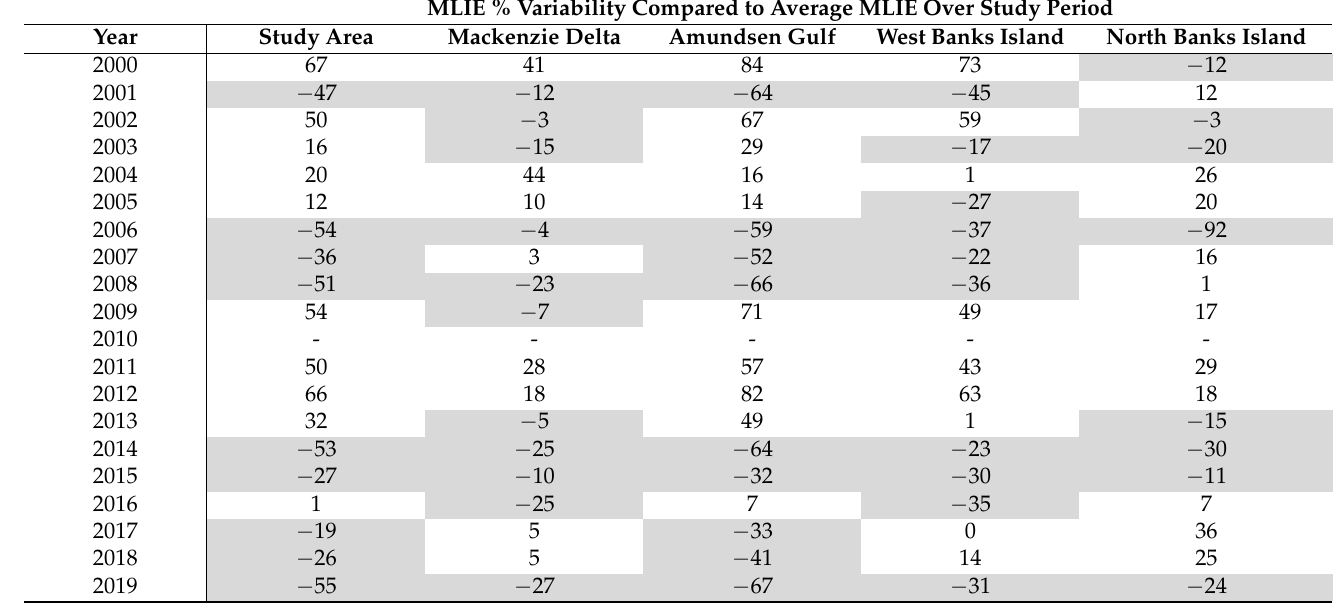
Table 1. MLIE pattern variability with rich or poor periods, shown in positive or negative relative % change compared to the average MLIE throughout the study period for the entire study area and each of the four regions. MLIE poor periods are highlighted in